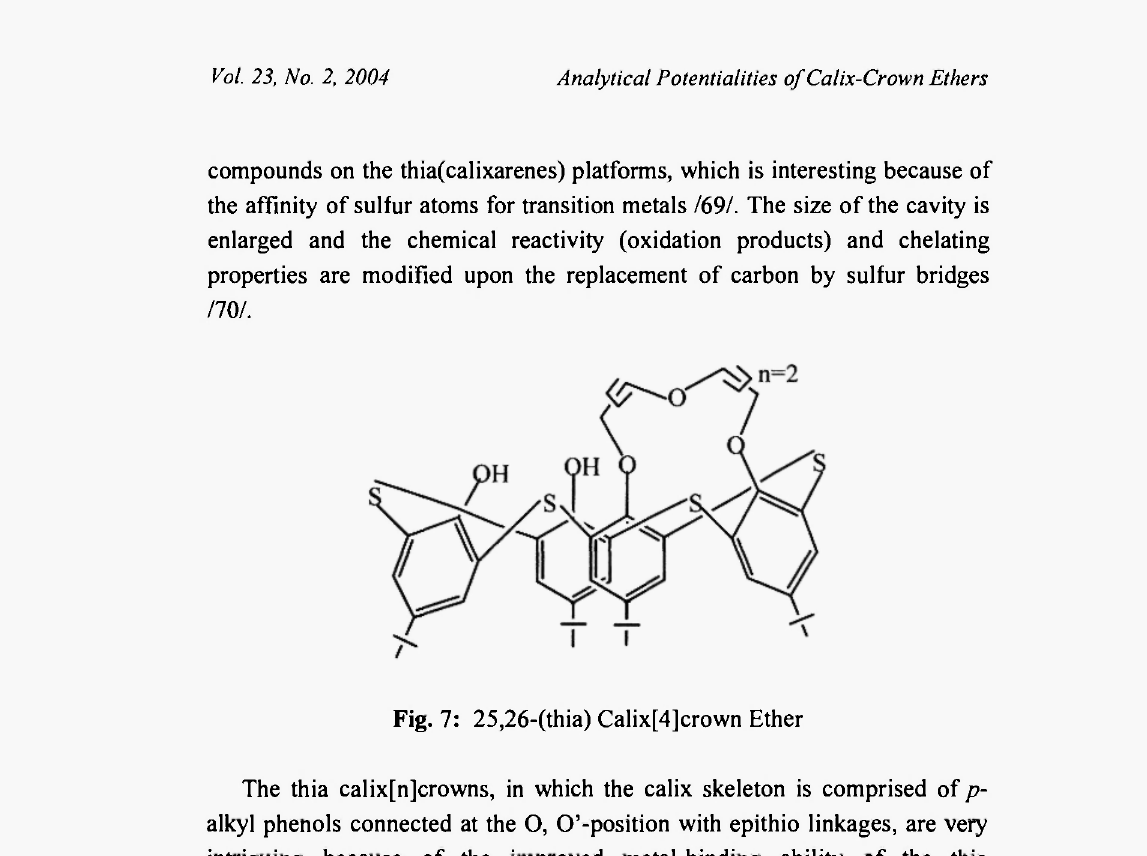
Fig. 7: 25,26-(thia) Calix[4]crown